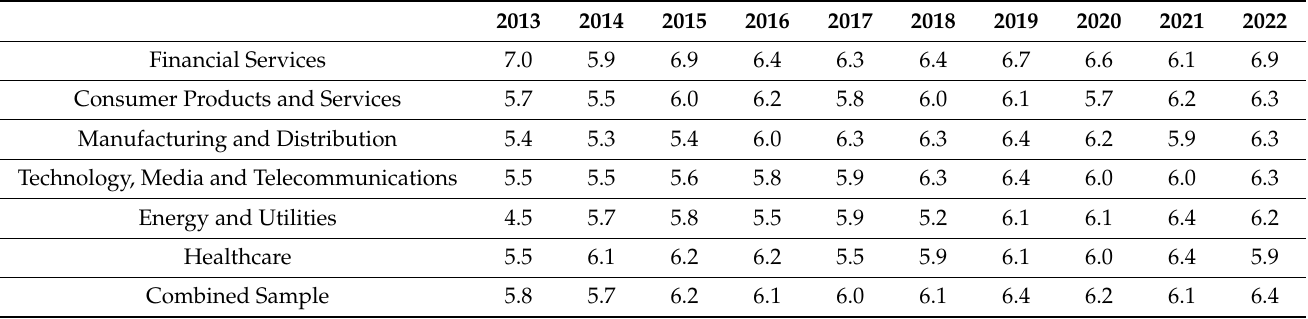
Table 5. Planned Level of Risk Management Investment by Industry and Survey Year. Survey Ques- tion: “Will your organization increase time and/or resources to risk identification and management over the next